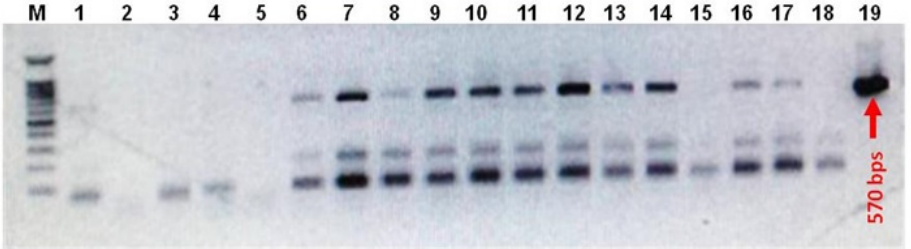
Figure 3. DNA gel electrophoresis of PCR screening for transgenic white and red Raphanus sativus L. plants. Shown is the ethidium bromide-mediated fluorescence of DNA fragments after UV excitation. Products of PCR screening of genomic DNA isolated from transgenic white and red Raphanus sativus L. plants were separated on a 1 % ( w / v ) agarose gel in 1x TAE for 50 min at 100 V. M: 100 bps DNA ladder, lane 1–12: PCR products of the screened white Raphanus sativus L plants, lane 13–17: PCR products of the screened red Raphanus sativus L. plants, lane 18: negative PCR water control, and lane 19: pTRA-PT-IFN- α 2a plasmid positive